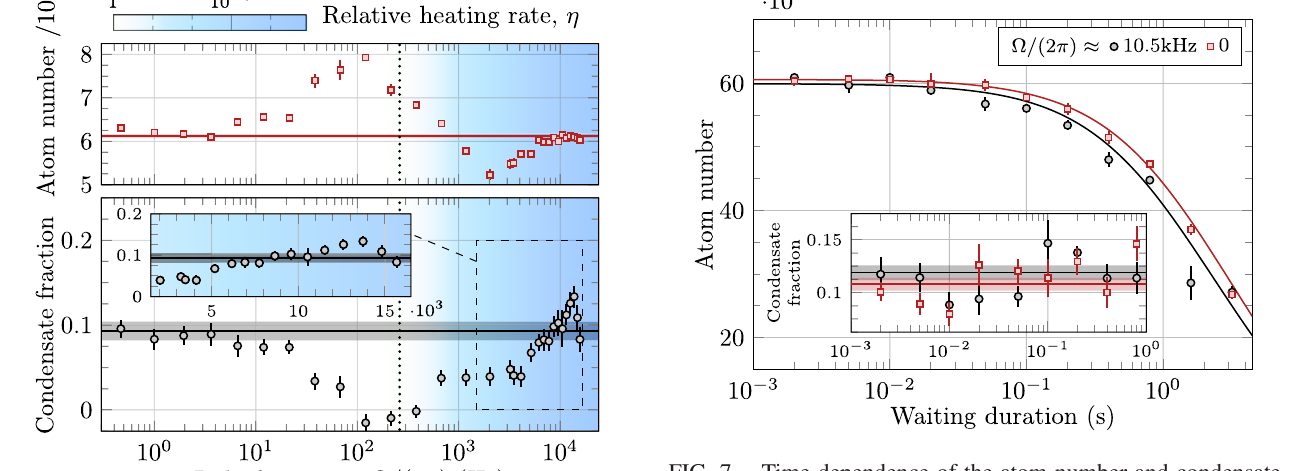
FIG. 7. Time dependence of the atom number and condensate fraction at unitarity. Data are taken after different waiting durations both with (black circles) and without (red squares) the rf driving. In both cases, the loss has a similar trend, which is well fitted by the model in Eq. (19) (solid lines). Inset: The condensate fraction (same marks) is plotted together with the weighted average (solid lines), and its standard deviation (shades) shows no decrease. Error bars are determined as in Fig.